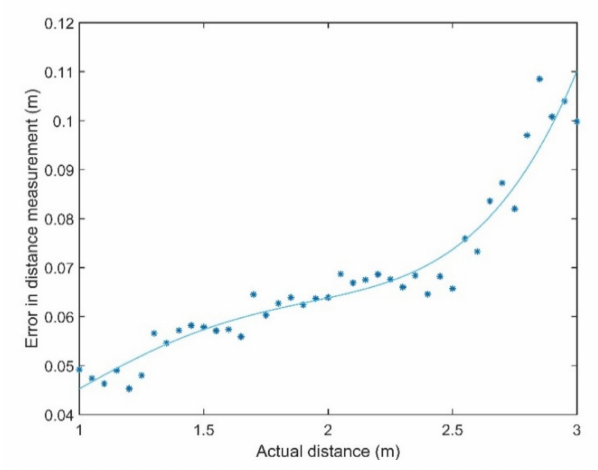
Figure 5. Variation of receiver delay with distance from the